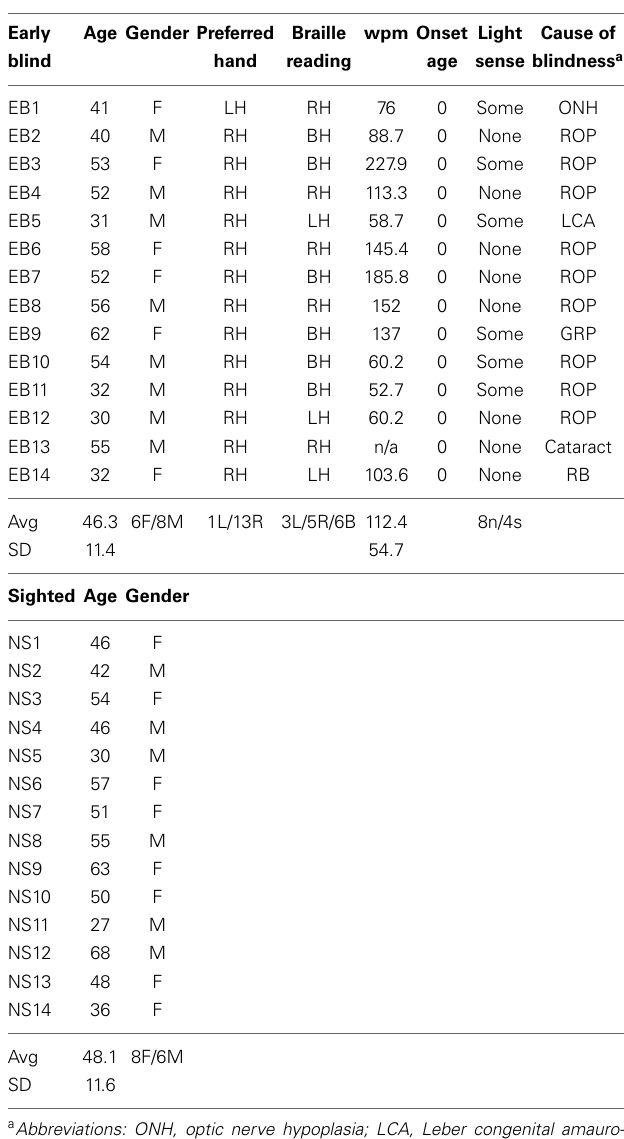
Table 1 | Early blind and sighted